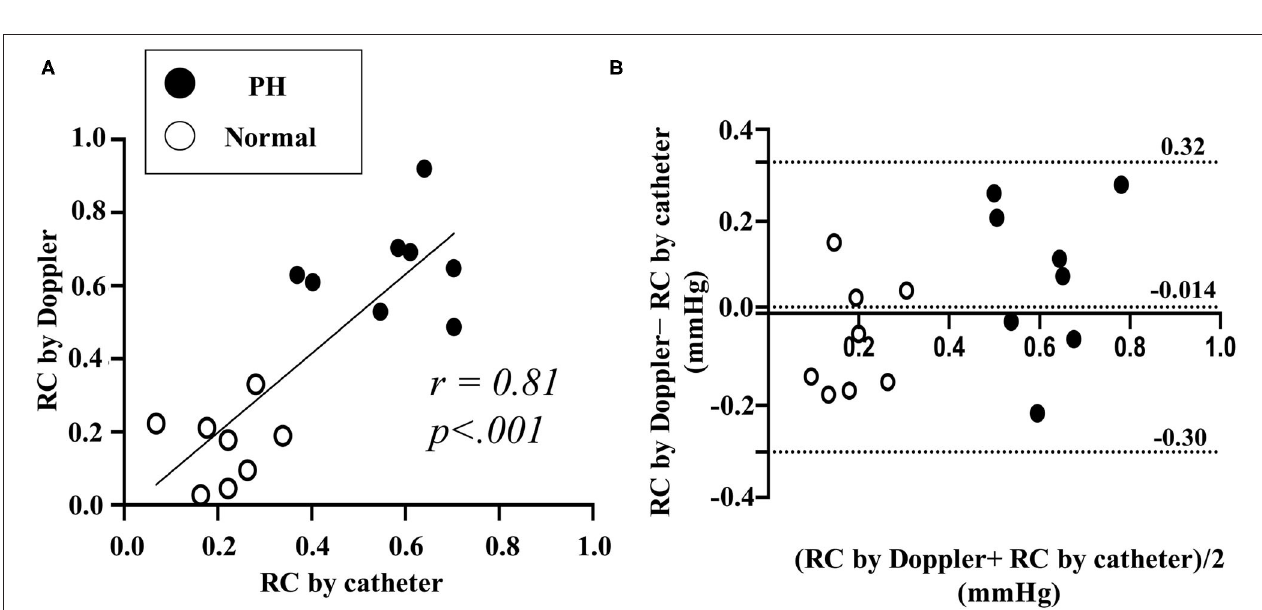
FIGURE 7 | Comparison between RC by catheter and by Doppler in validation study using experimental Dog (Representative original imaging). (A) , Linear correlation between RC by the catheter and by the Doppler. (B) , Bland-Altman analysis for RC by catheter and by Doppler. RC, reflection coefficient which calculated as the ratio of peak Pb to peak Pf. Black dot represents the result of RC in pulmonary hypertension (PH). White dot represents the result of RC in normal condition.